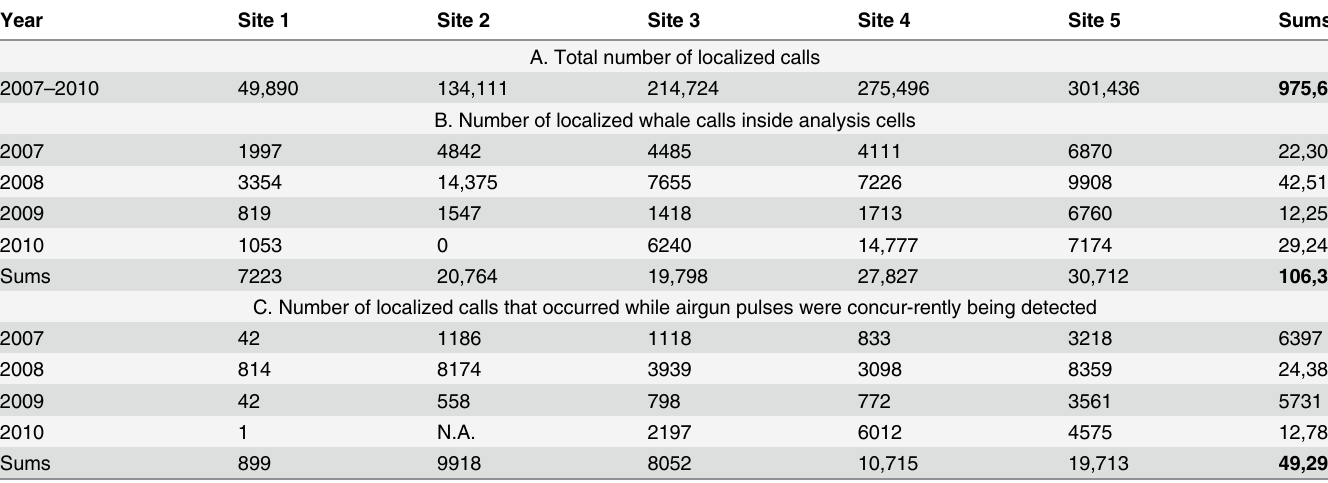
Table 3. Numbers of localized whale